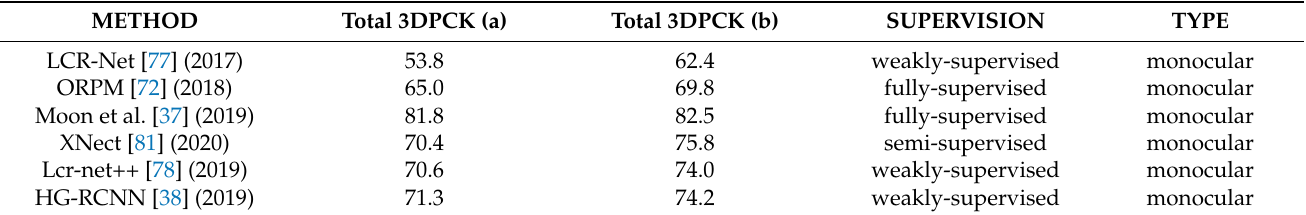
Table 4. Summary of the state-of-the-art multi-person 3D pose estimation methods on MuPoTS-3D dataset.